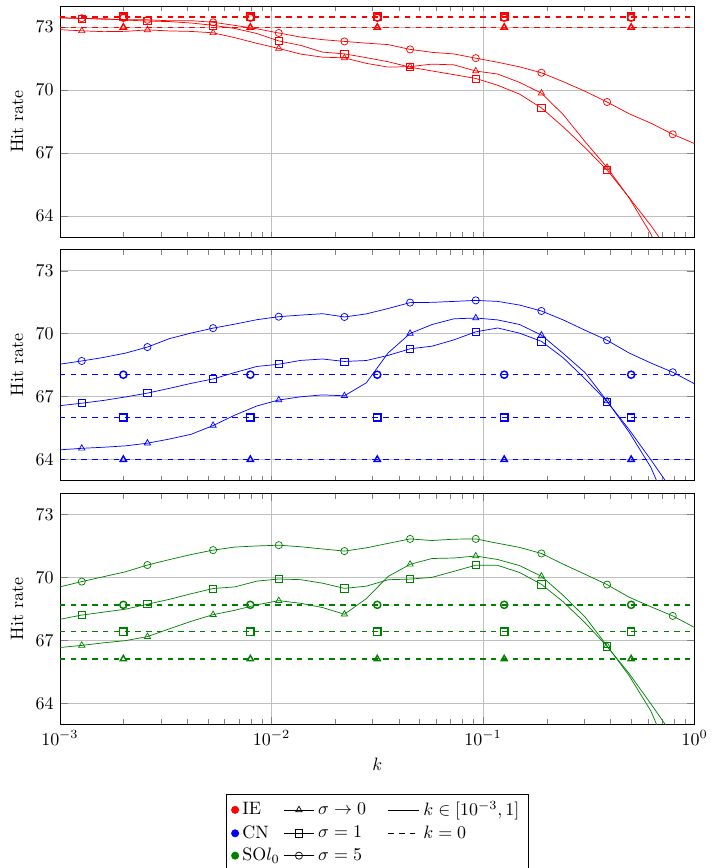
Figure 11. ( Top ) to ( bottom ) We see the hit rate at a geodesic error of 0.25 from the centaur shapes obtained by three different numerical schemes. The colours and rows distinguish between the different solvers we used: (red, ( top )) IE, (blue, ( middle )) CN and (green, ( bottom )) SO l 0 . Solid lines indicate a changing damping parameter k and dashed lines for a fixed ( k = 0) one. The symbols distinguish between the different widths σ of the Gaussian distributed initial